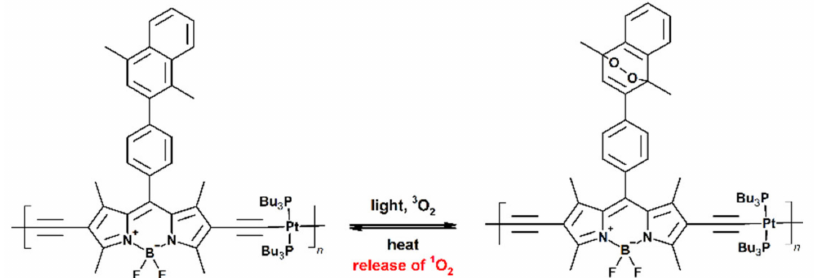
Figure 7. Schematic representation of PDT agent with 1 O 2 -carrier units (investigated in